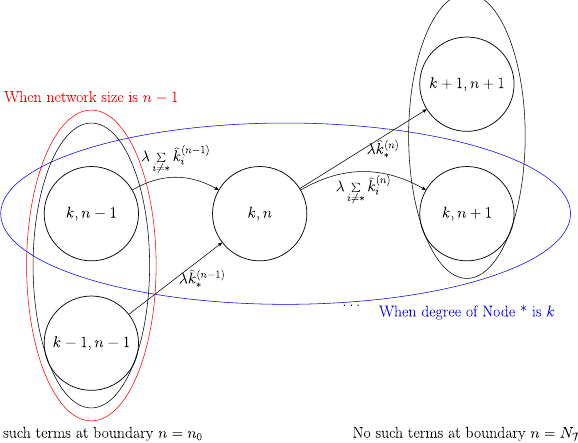
Figure 4. The state transition rate diagram of a two-dimensionalMarkov chain for a specific node * — where k denotes its degree and n denotes the network size that this node * is in, with values n 0 and  N respectively at its initial time and time  . In the diagram, it is noted